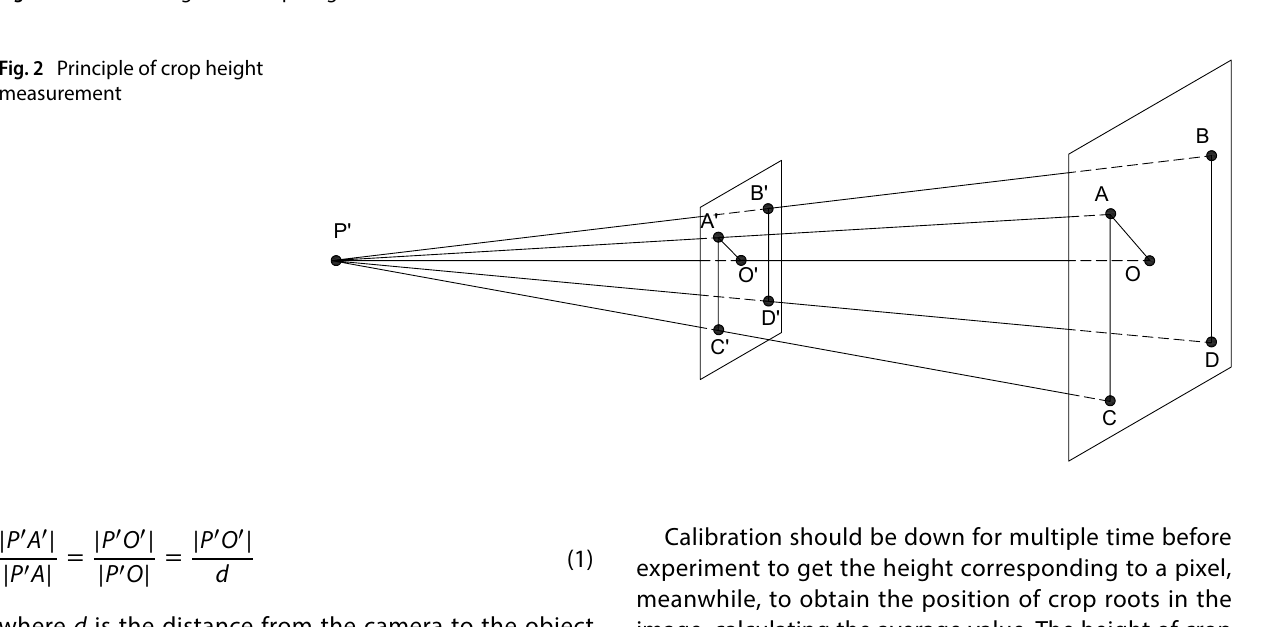
Fig. 1 Schematic diagram of crop height measurement